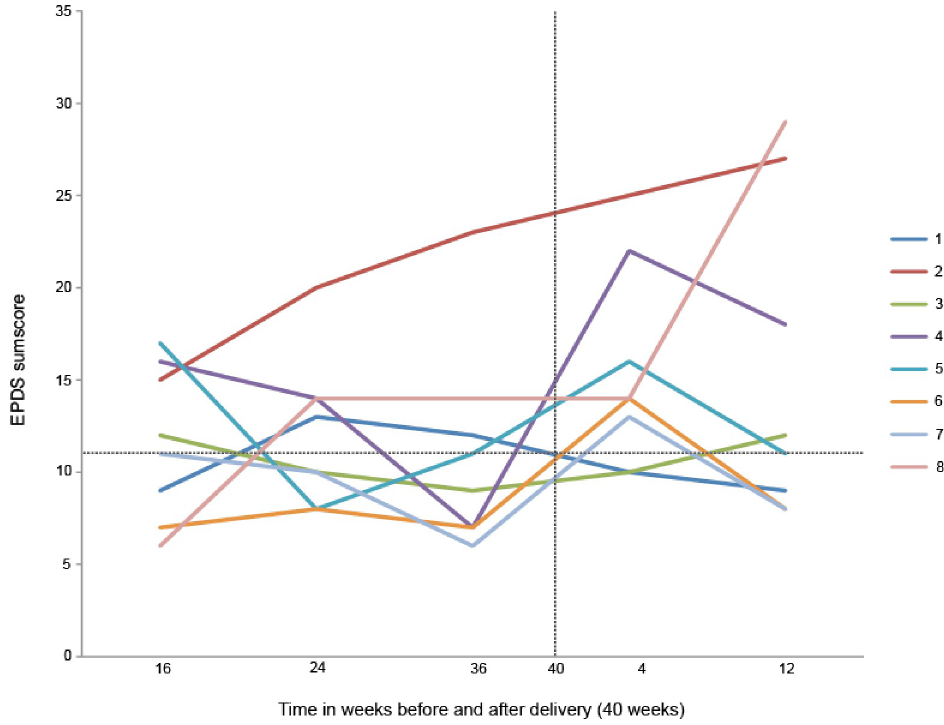
Fig 3. Edinburgh Perinatal Depression Scale (EPDS) sum score in the perinatal period. Each line represents a case with recurrence of depression. Case numbers match with case numbers listed in Table 2. The horizontal dotted line represents the EPDS cut-off